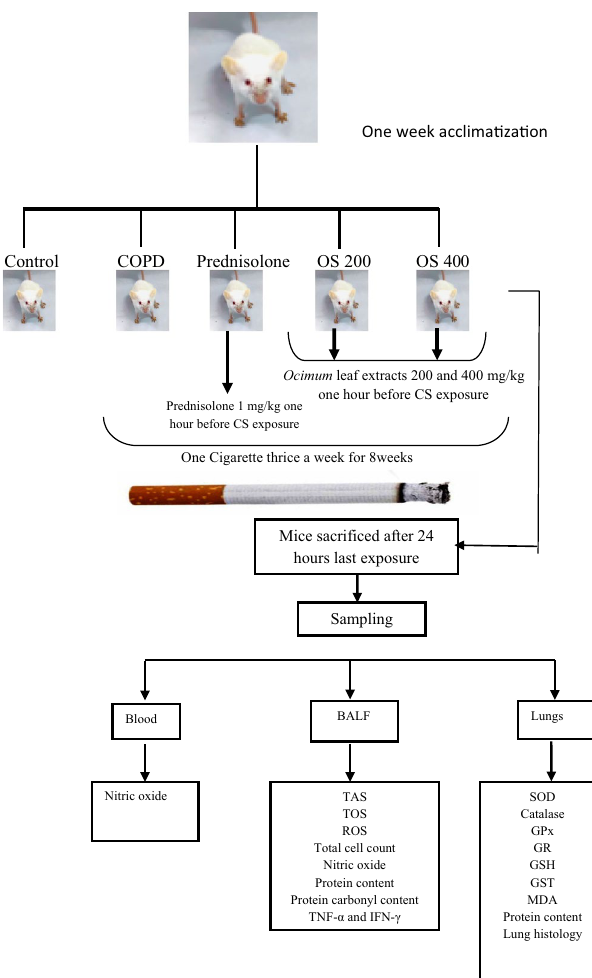
Figure 15. Schematic diagram of animal experimentation and protocol.